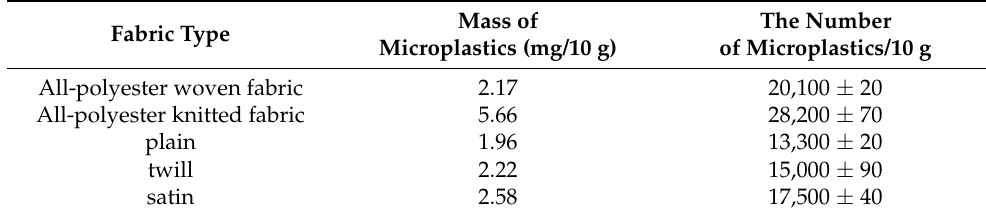
Table 12. Quantity of